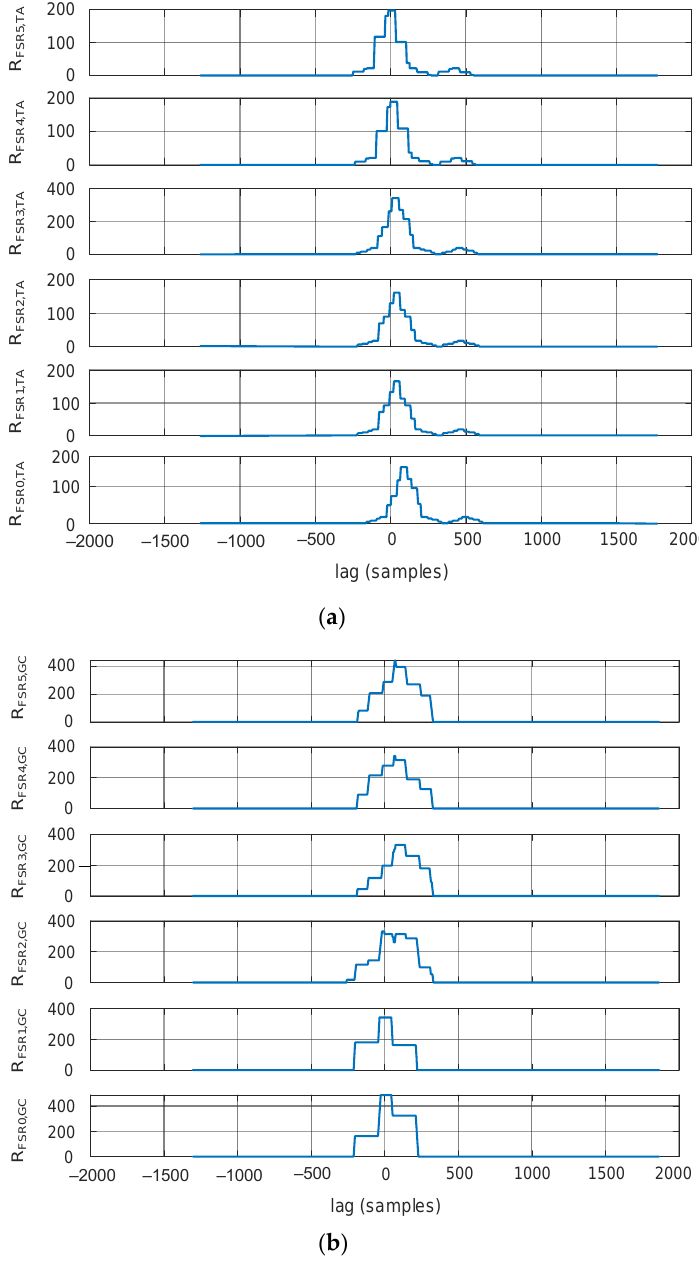
Figure 21. Cross-correlation of the FSRs to the ( a ) tibialis anterior and the ( b ) gastrocnemius. The cross-correlation results plotted in Figure 21 enable the formulation of the gait map listed in Table 6. Indeed, the cross-correlations plotted in Figure 21 illustrate the interdependency of the investigated plantar pressure point with muscular activity during gait. On the cross-correlation plots, we have identified the lags corresponding to the middle of each gait cycle. Then, we have compared the cross-correlation function magnitude to a threshold level equal to 0.75 of the cross-correlation maxima, having the 0.75 fraction determined empirically. Cross-correlation magnitudes larger than the threshold account correlation of the plantar pressure with the muscle in the respective gait cycle, i.e., logical ‘1′ in the gait map, whereas cross-correlation magnitudes below the